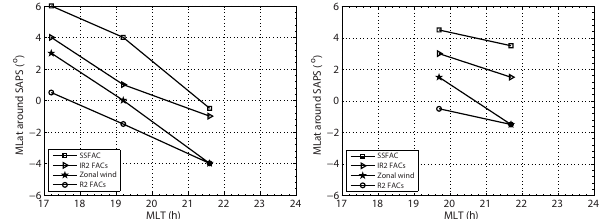
Figure 7. The MLat of peaks in the SSFACs, integrated downward R2 FACs (IR2), westward zonal wind, and downward R2 FACs as a function of MLT during the first orbit after SAPS occurrence.